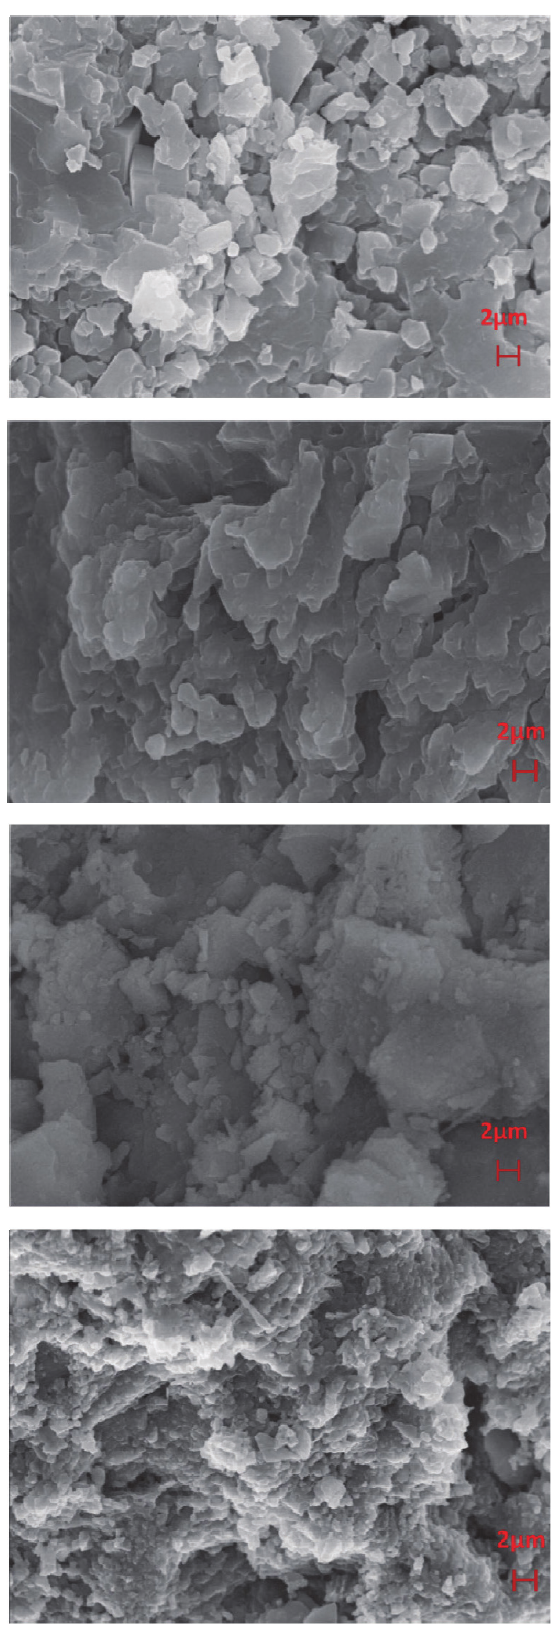
Fig. 3 – SEM analysis of Original carrier without micro- organism (a), Modified carrier without microorganism (b), Original carrier with immobilized microorganism (c), and Modified carrier with immobilized microorganism